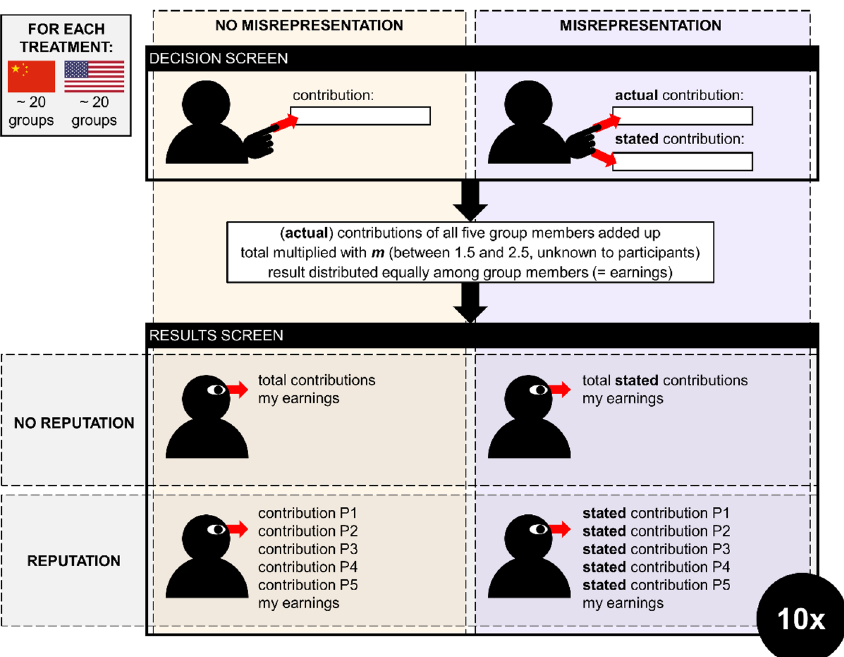
Figure 1. Overview of the experimental design. The experiment was run online and consisted of four experimental treatments: all combinations of the possibility for misrepresentation (with or without) and the possibility for reputation (with or without). Participants received an endowment of five Points and had to enter a contribution to the group project on the ‘Decision screen’. They entered either their actual contribution (treatments without misrepresentation, left side of figure in yellow) or both an actual contribution and a stated contribution (treatments with misrepresentation, right side of the figure in purple). On the ‘Results screen’, participants were shown the actual contributions (treatments without misrepresentation) or the stated contributions (treatments with misrepresentation) of the group members. In the treatments without reputation, individuals were only shown the total (stated) contributions of all group members, whereas they were shown all individual (stated) contributions in the treatments with reputation. In all treatments, the Results screen also showed the participant’s own earnings of the round, which consisted of an equal share of the total Points invested in the group project multiplied with m (which could take any value between 1.5 and 2.5, see “Methods”) and the Points the individual did not invest in the group project. After the Results screen, the participants started a new round on the Decision screen (in the same group), for a total of ten